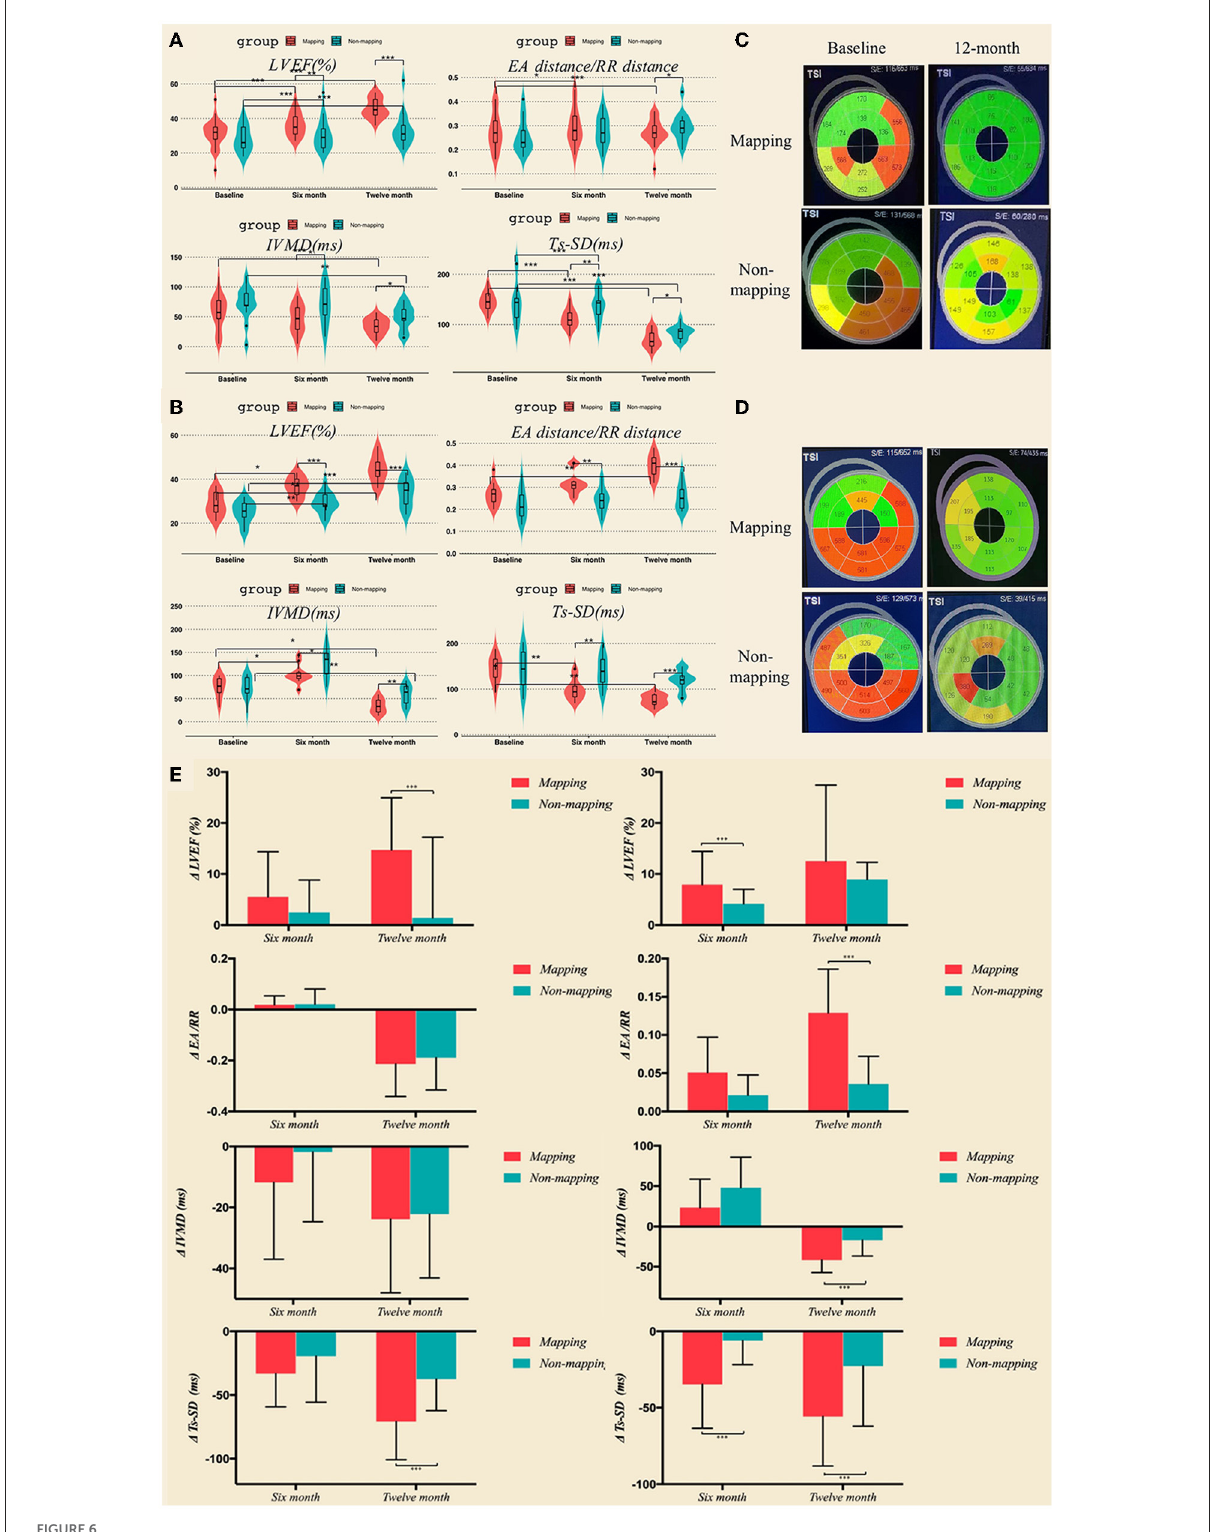
FIGURE6 LVEF and synchronization parameters including EA distance/RR duration, IVMD, and Ts-SD 12 in LBBAP (A) and CVP (B) at baseline, 6 months, and 12 months after the operation measured by transthoracic echocardiography. (C,D) Bulls-eye view of real-time three-dimensional echocardiography at baseline and 12 months after the operation. (E) LVEF and synchronization parameters variation in LBBAP and CVP group at 6 months and 12 months. * p < 0.05; ** p < 0.01; *** p < 0.001. CVP, coronary venous pacing; LBBAP, Left bundle branch region